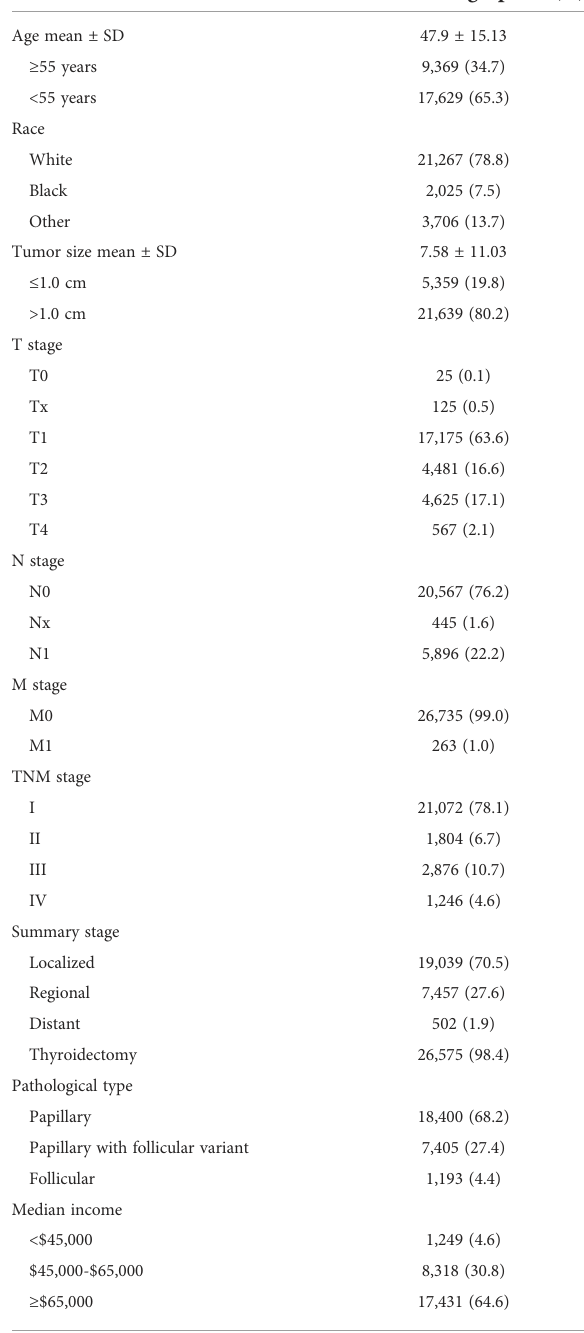
TABLE 1 Characteristics of 26,998 patients with FDTC in